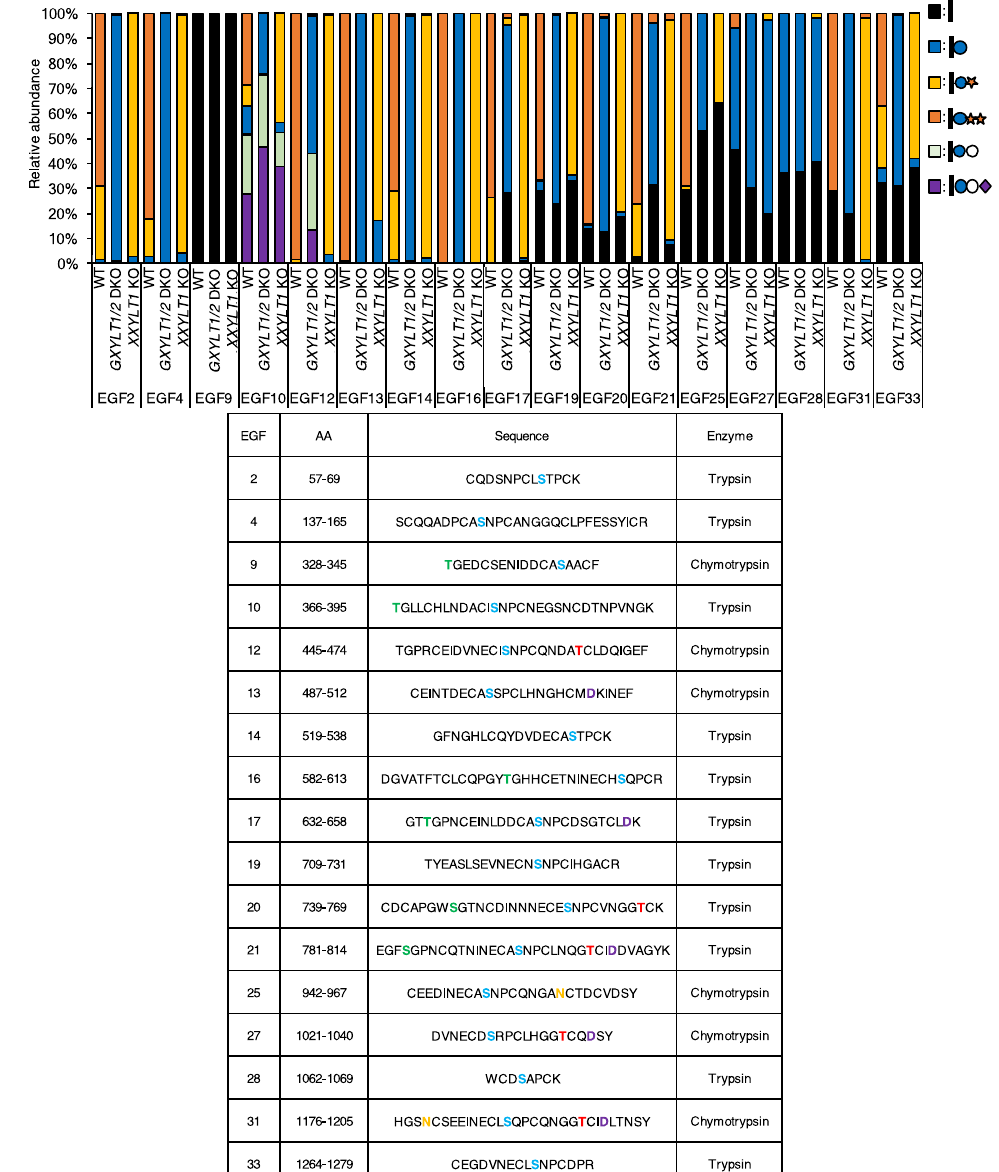
Figure 2. Epidermal growth factor-like (EGF) repeats from NOTCH1 are modified with O -Glc trisaccharides. Mass spectrometric analysis of O -Glc glycans on mouse NOTCH1 produced in wild type control cells, GXYLT1/2 double knockout (DKO) cells, and XXYLT1 knockout (KO) cells. Samples were generated in wild type control HEK293T cells, GXYLT1/2 DKO cells, and XXYLT1 KO cells transfected with the plasmids encoding the mouse NOTCH1 ECDs as described in Experimental Procedures. The data are derived from the analysis of mouse NOTCH1 EGF1-18, mouse NOTCH1 EGF19-36, and mouse NOTCH1 EGF24-28. MS/MS spectra confirmed the identity of (glyco)peptides based on the presence of peptide-specific b- and y- ions and the neutral loss of the predicted glycans. Spectra of MS/MS are shown in Figure S1. The sequence of peptides, the predicted and measured mass ( m / z ), and the charge state are summarized in Table S1. Quantification was performed using the height of the EICs and the total amount of detected (glyco)peptides with different glycoforms is set at 100%. Data are derived from at least two biological replicates. Further details are shown in Table S1. Colored letters in the sequences of the table show the predicted post-translational modification sites. Blue— O -Glc; red— O -Fuc; green— O -GlcNAc; yellow— N -glycan; purple— β